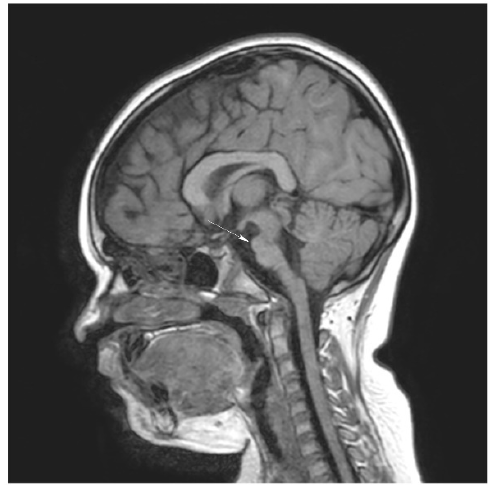
Figure 2. MRI brain imaging showing hypoplasia of the brainstem.